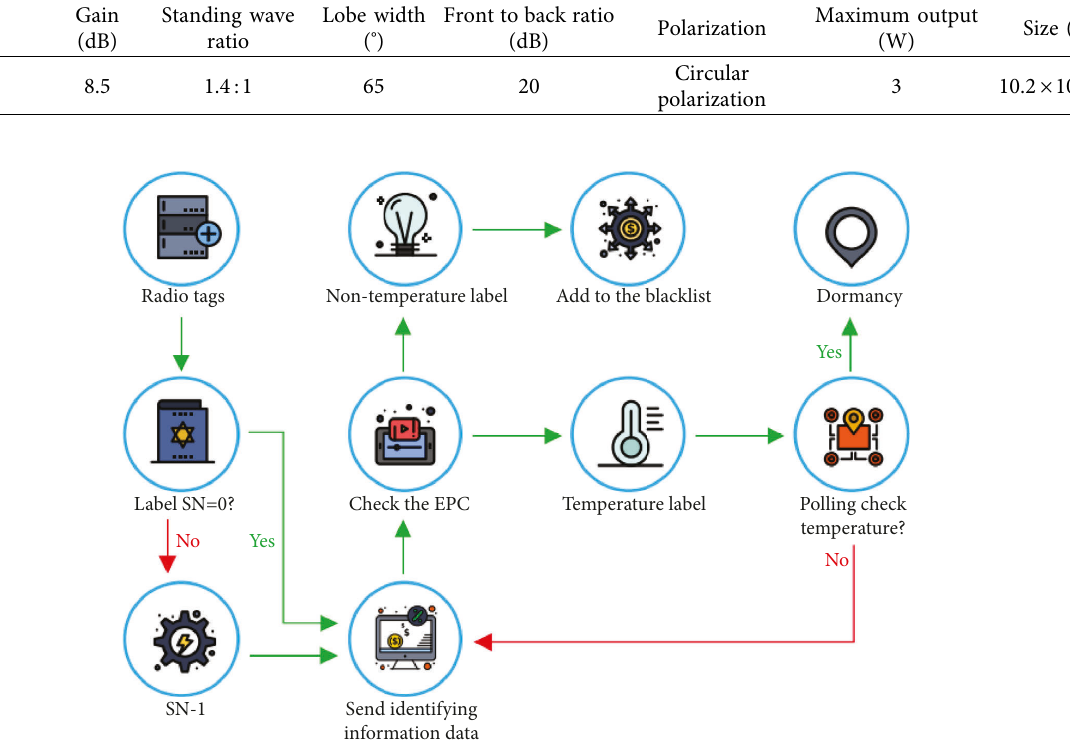
Figure 2: ALOHA polling mechanism based on dynamic frame time slot (high